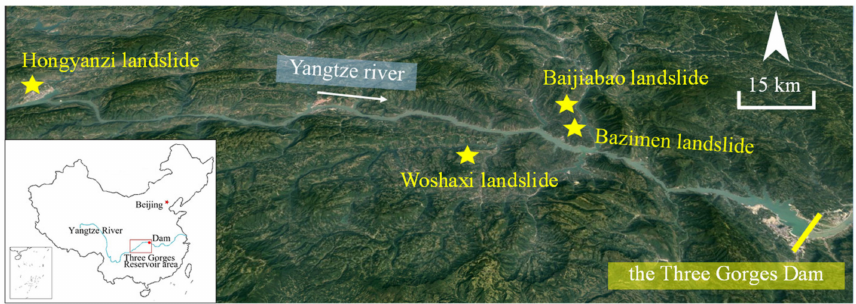
Figure 1. Location map of landslides in TGRA mentioned in the